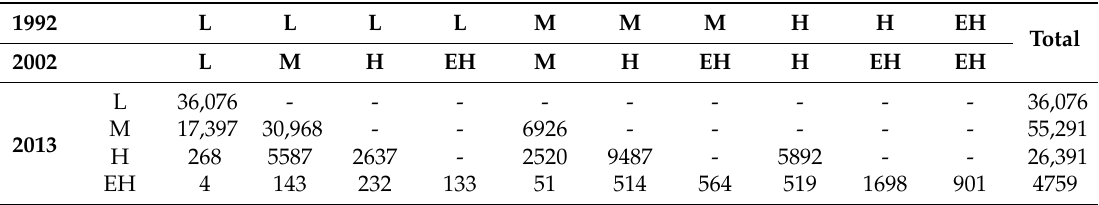
Table 3. Pixel count of transition types for initial lit areas across Southeast Asian countries between 1992, 2002 and